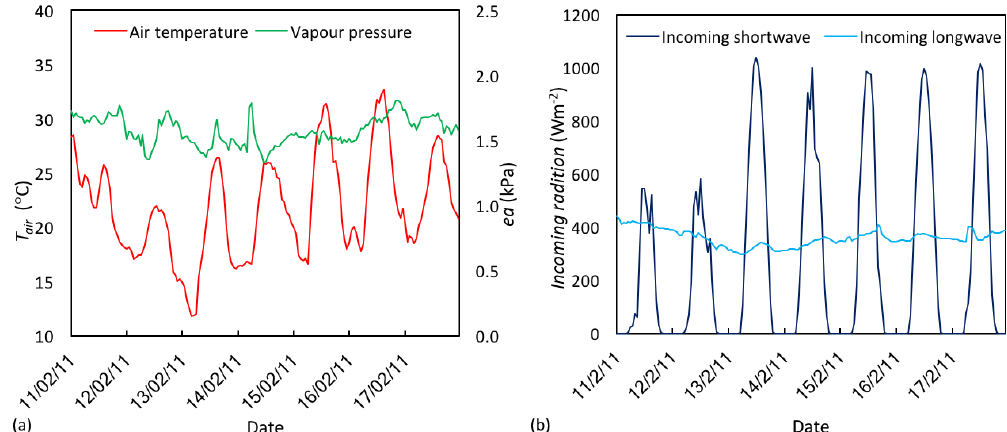
Figure B2. Meteorological condition during the Mawson Lakes field campaign. Data source: Bureau of Meteorology Parafield Airport (ID: 023013) and Kent Town (ID: 94675) weather stations, Adelaide.